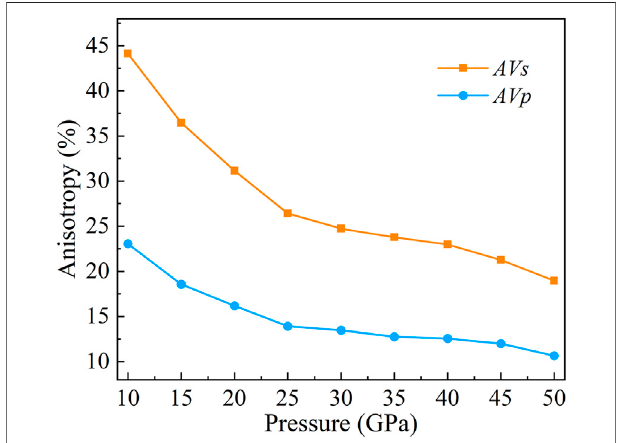
FIGURE 11 | Anisotropy of CaO 3 at 10 – 50 GPa. The orange squares represent AVs , and the blue circles represent AVp .